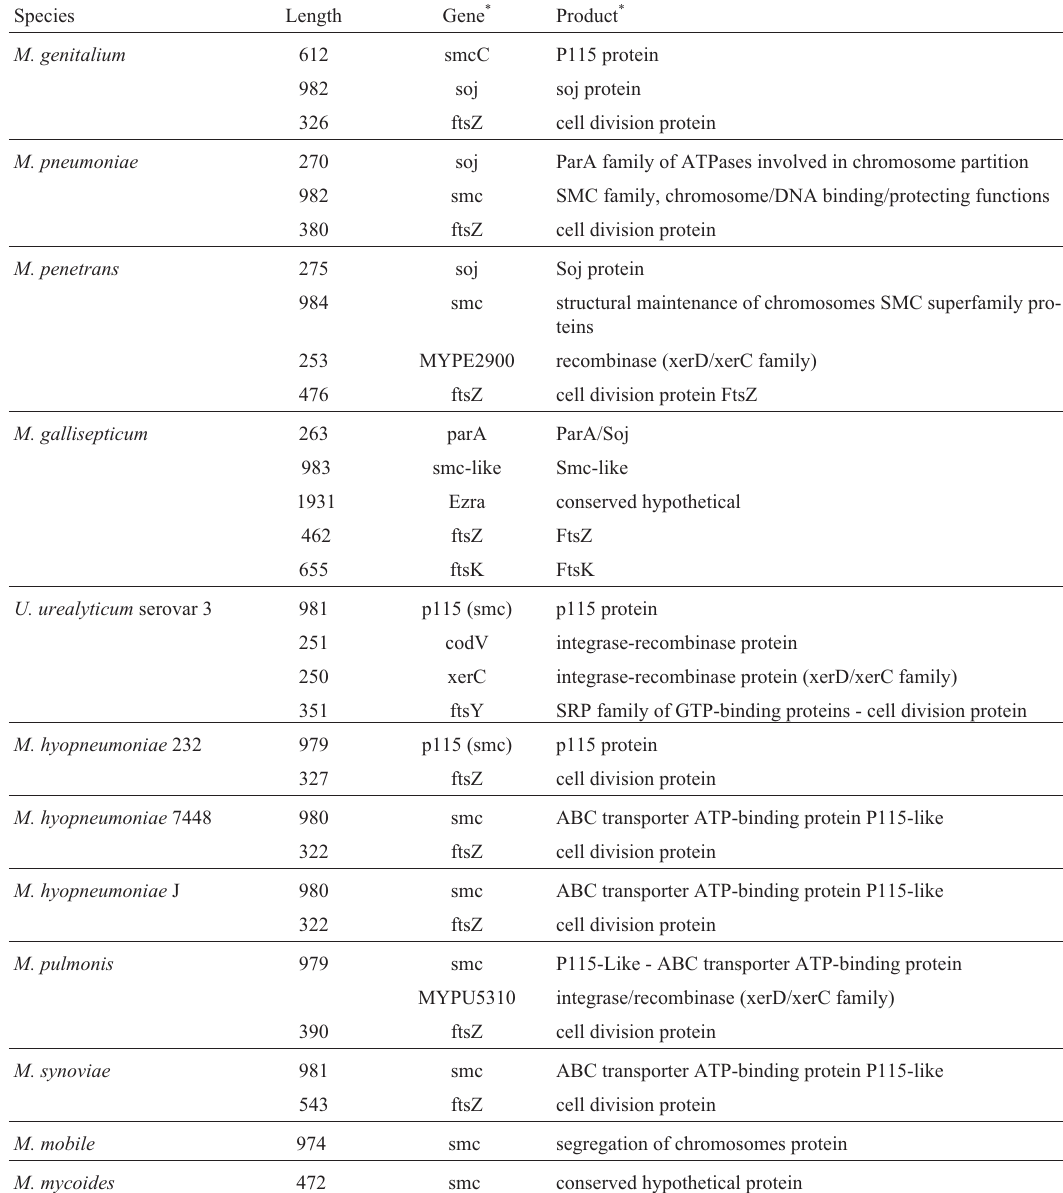
Table 1 - Putative genes involved in cell division in mycoplasmas. Genomes of ten different Mycoplasma species have been compared. Data from three different strains of Mycoplasma hyopneumoniae are presented.